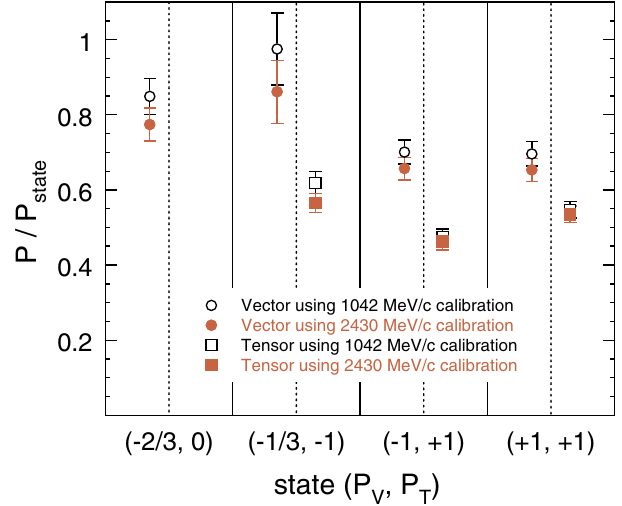
FIG. 2. (Color) Ratios of the vector and tensor deuteron polar- izations to the ideal value of each polarization state from the source are plotted against the polarization state number for the 1850 MeV =c COSY deuteron beam. The open symbols indicate data points using the 1042 MeV =c calibration while the solid symbols indicate data using the 2430 MeV